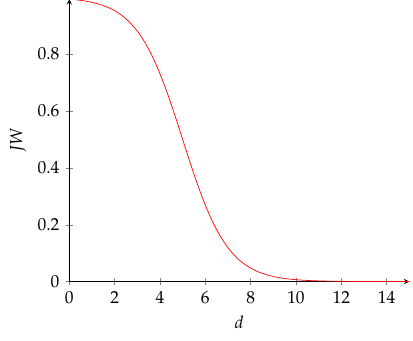
Figure 2. JW (cid:48) s function graph ( θ =